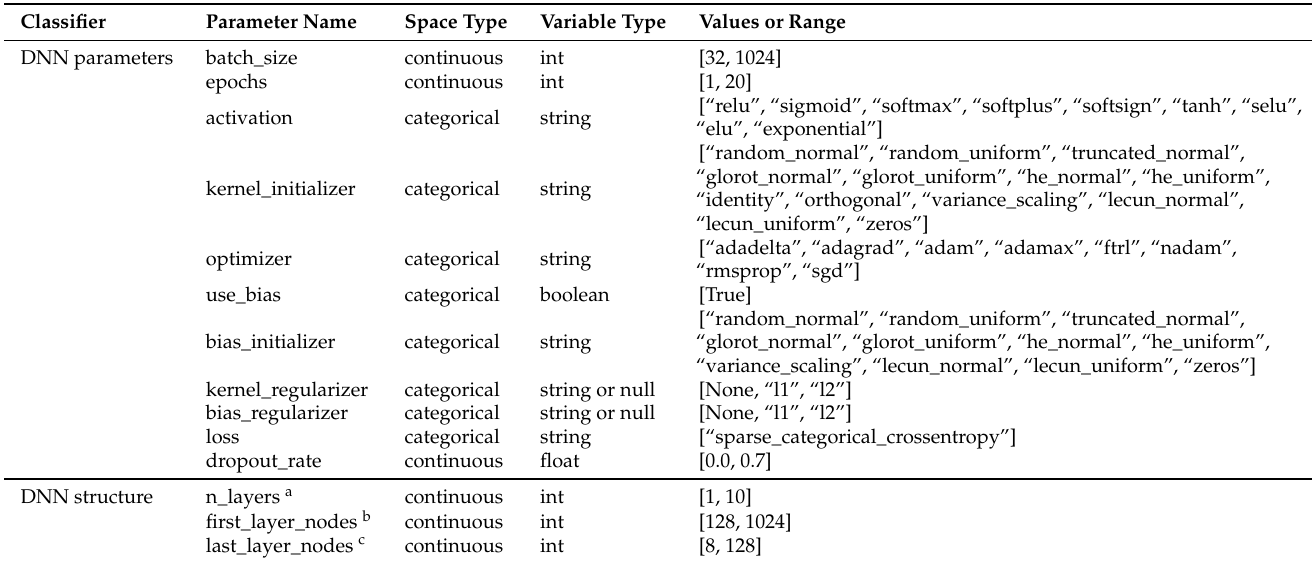
Table A2. Parameters and their values and ranges considered for EO hyperparameter search: the case of DNN.